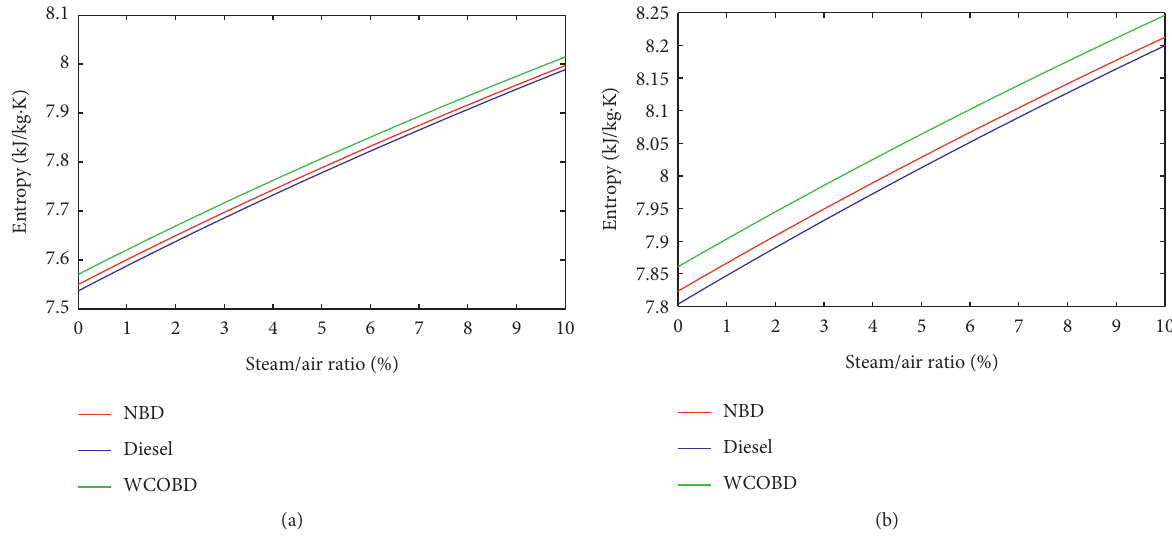
Figure 13: Variation of gas mixture entropy with steam injection